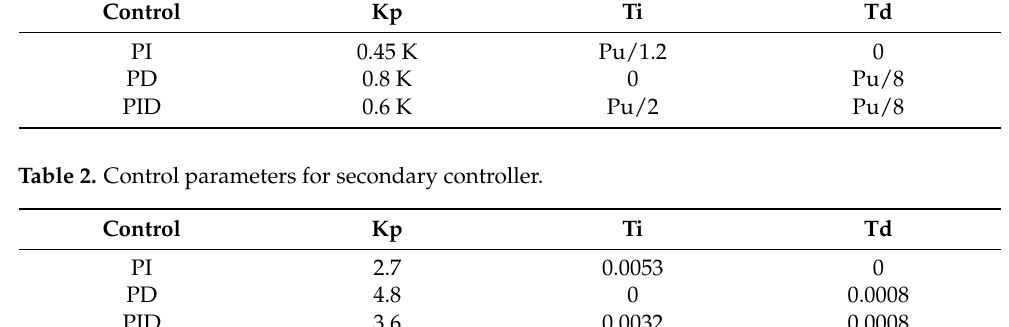
Table 1. Control parameters using Ziegler Nichols method.